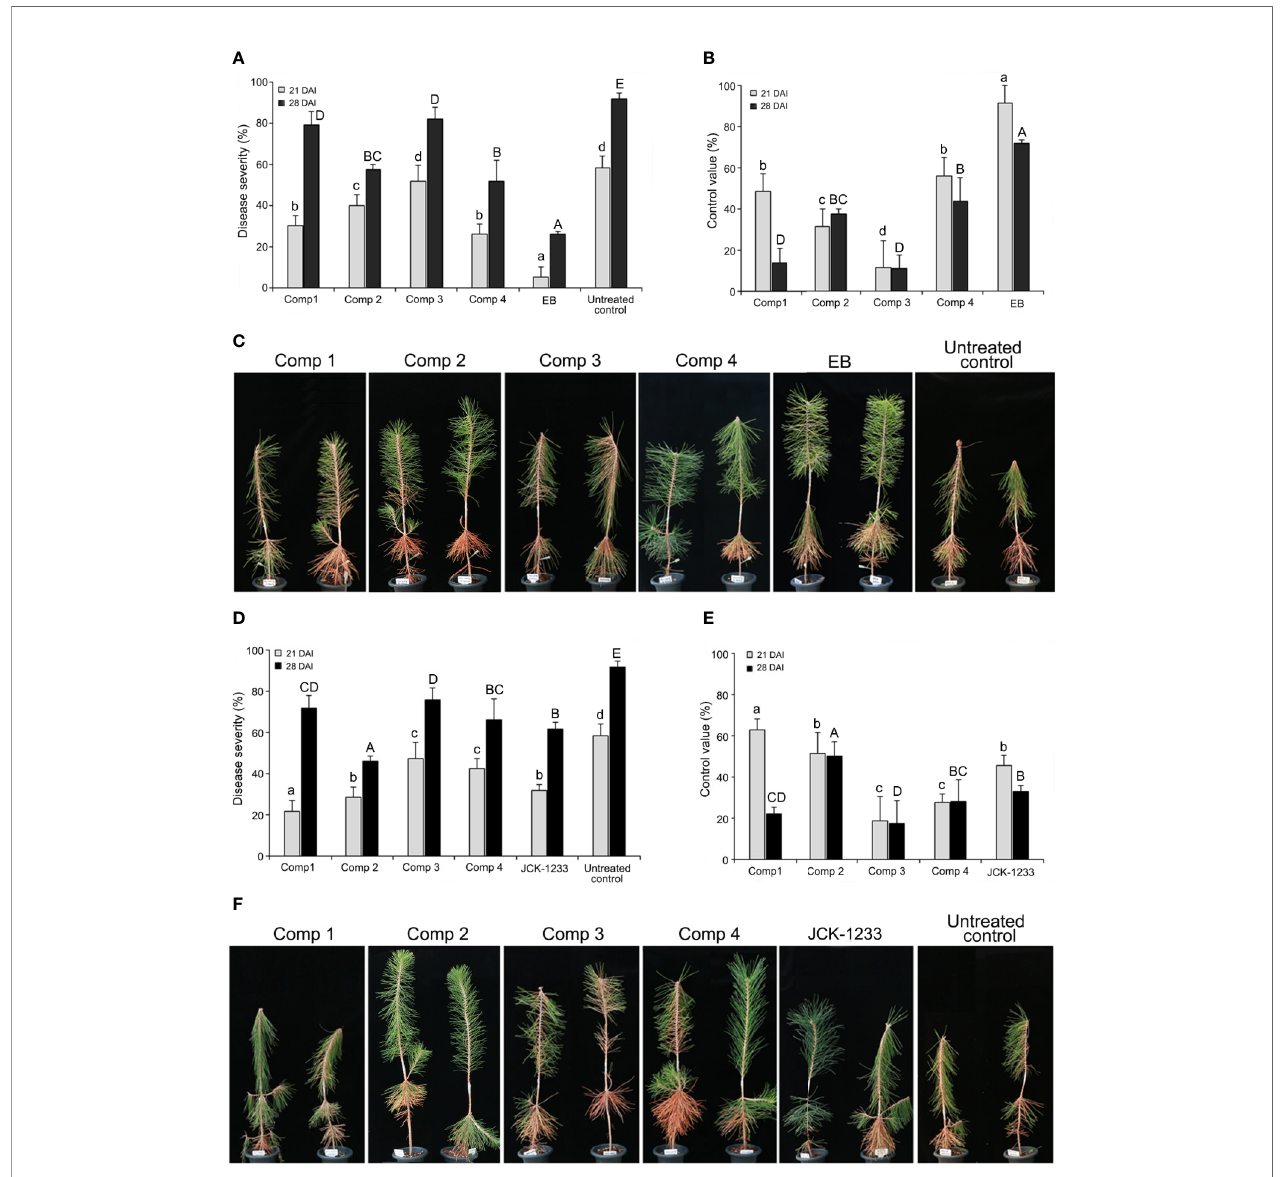
FIGURE 4 | Effect of trunk injection and foliar spray treatments with diketopiperazines on pine wilt disease (PWD). (A) Disease severity and (B) disease control ef fi cacy of diketopiperazines against PWD at 21 and 28 days after inoculation (DAI) by trunk injection. (C) Photographs of the PWD wilting symptoms on pine seedlings treated with diketopiperazines by trunk injection at 28 DAI. (D) Disease severity and (E) disease control ef fi cacy of diketopiperazines against PWD at 21 and 28 DAI by foliar spray. (F) Photographs of the PWD wilting symptoms on pine seedlings treated with diketopiperazines by foliar spray at 28 DAI. Comp 1, cyclo - (D-Pro-L-Val); Comp 2, cyclo -(L-Pro-L-Ile); Comp 3, cyclo -(L-Pro-L-Phe); Comp 4, cyclo -(L-Leu-L-Val); EB, emamectin benzoate as a positive control. Error bars represent standard deviation from fi ve replicates. Data was represented as the mean and standard error of two runs with fi ve replicates per run. Different lower and upper case letters shown values that are signi fi cantly different ( p < 0.05) level by Duncan ’ s test with data at 21 and 28 DAI,